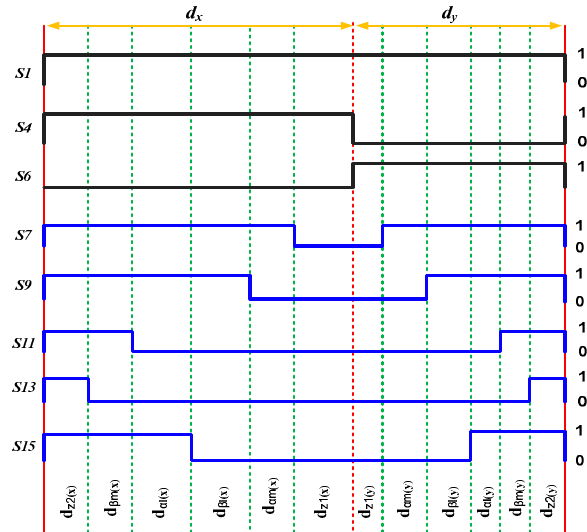
Figure 6. Switching outline of the five-phase IMC in half of the sample duration.